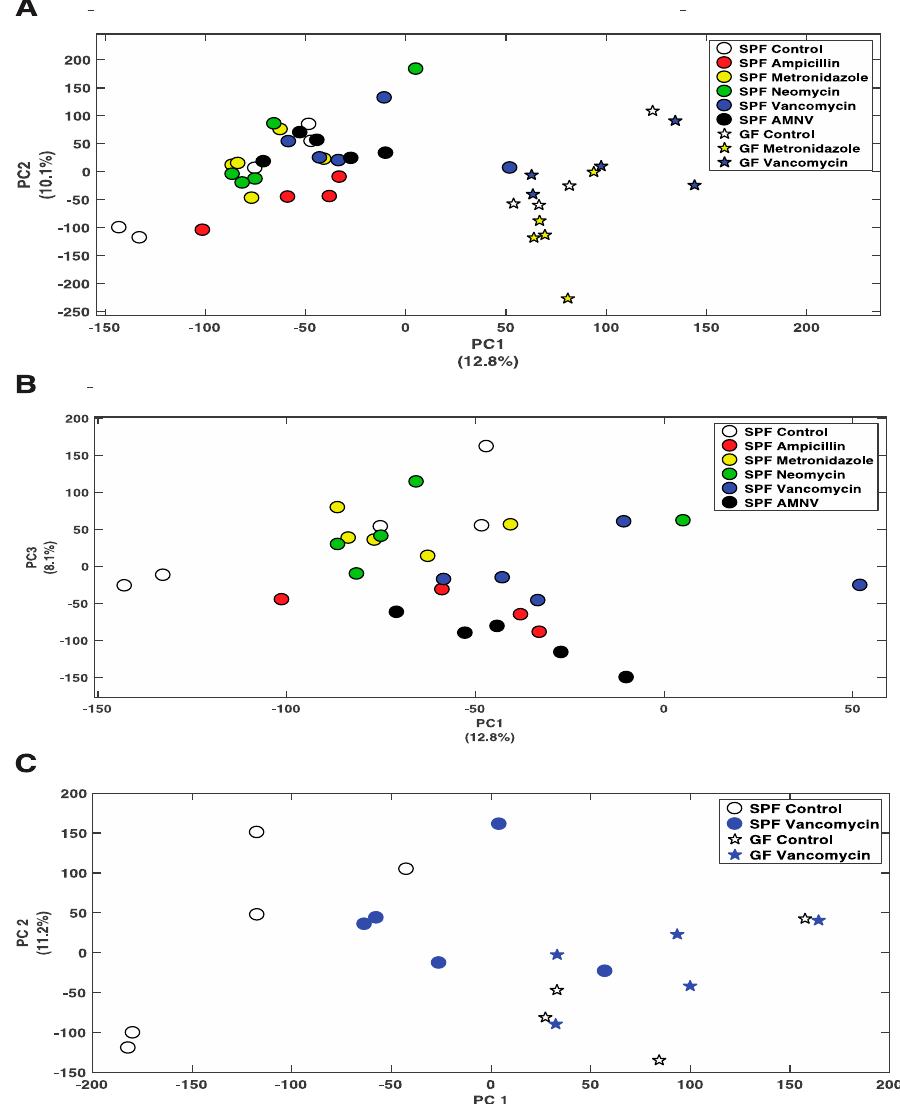
Figure 5. Nuclear Magnetic Resonance (NMR) analysis of polar metabolites isolated from liver extracts. ( A ) PCA plot showing the distribution of SPF and GF mice, with colored symbols corresponding to the different treatments given on the right of the panel. ( B ) PCA plot showing the distribution of SPF mice with colored symbols corresponding to the different treatments given on the right of the panel. ( C ) PCA plot showing the distribution of SPF and GF mice that were treated with vancomycin, as well as their untreated counterparts, with colored symbols for the different treatments given on the right of the panel. For all PCA plots, the percentage of variance explained by each axis is indicated next to its axis